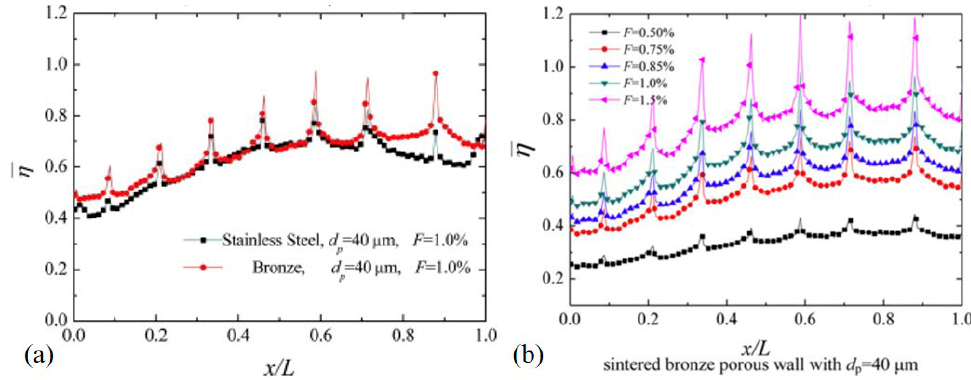
Figure 29. Influences of ( a ) porous matrix thermal conductivity and ( b ) injection ratios on the transpiration cooling efficiency. Reprinted with permission from [118]. Copyright 2012 Elsevier.